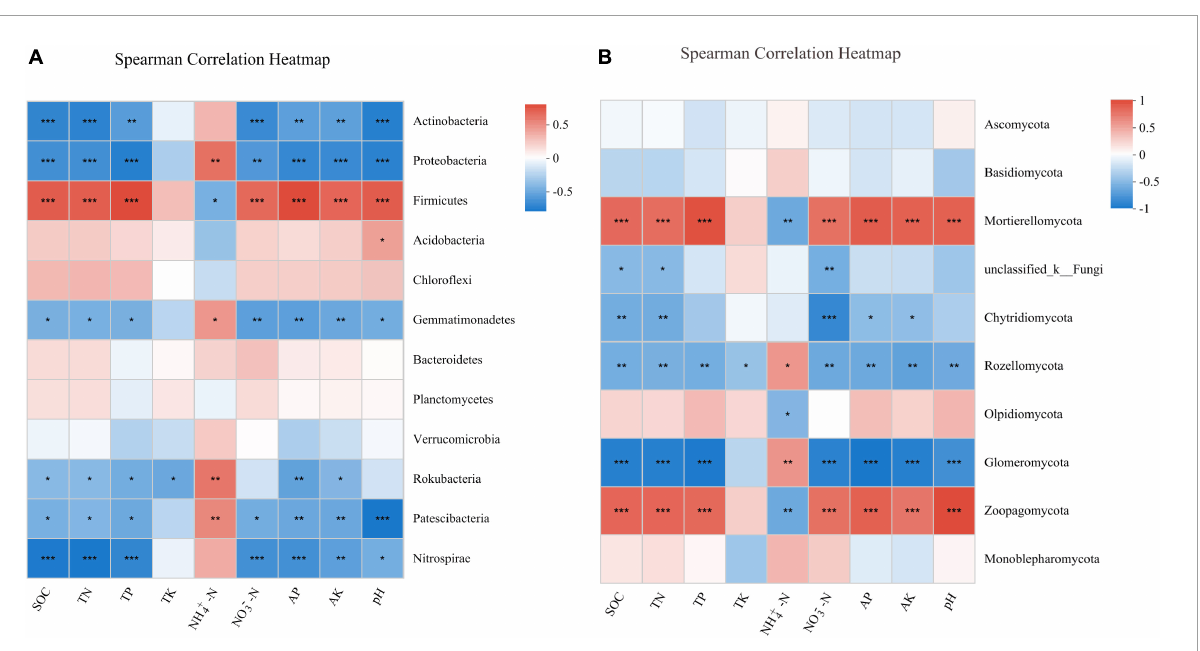
FIGURE5 Spearman’s correlation analysis between soil properties and the relative abundance of bacterial (A) and fungal (B) phylum under different treatments. * P < 0.05; ** P < 0.01; *** P <